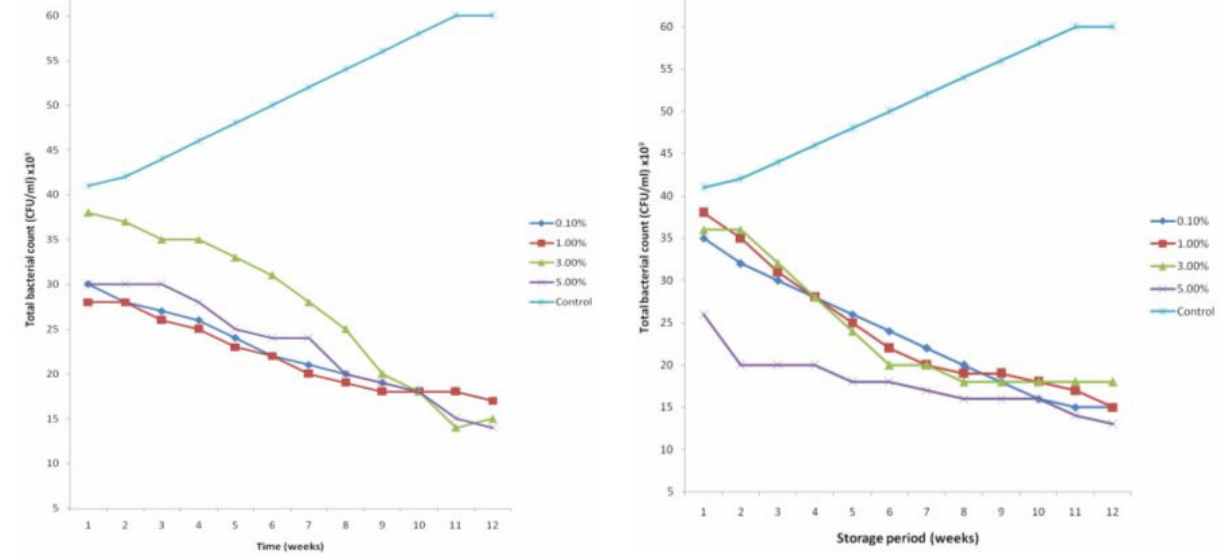
Fig. 4. Changes in the total bacterial counts of varying concentrations of citric acid preserved powder of mango seed kernels stored at room temperature for 12 week